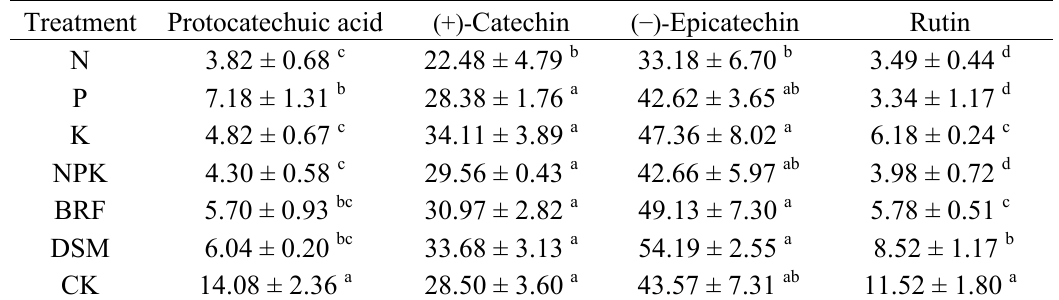
Table 2. Phenolic compounds in the jujube fruit grown by different fertilizers (mg/100g FW).